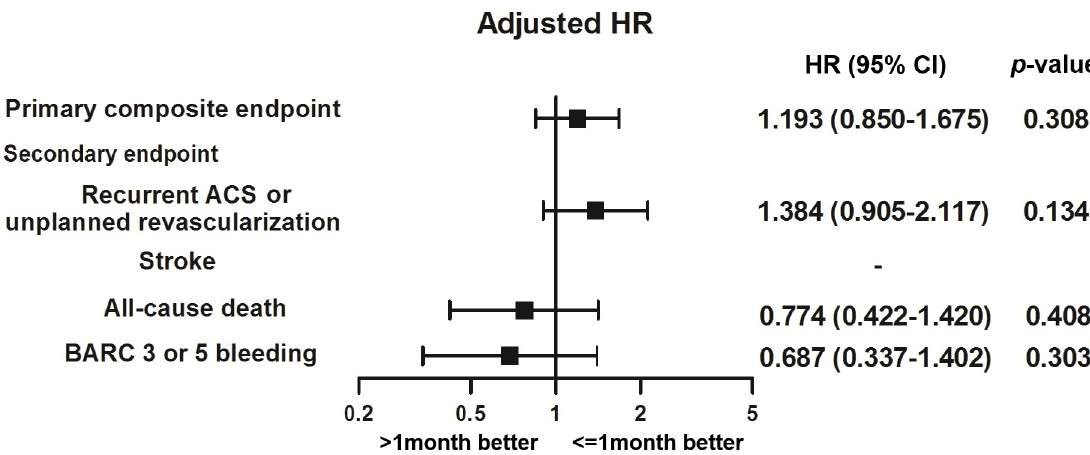
Fig 1. Clinical outcomes at 12-month follow